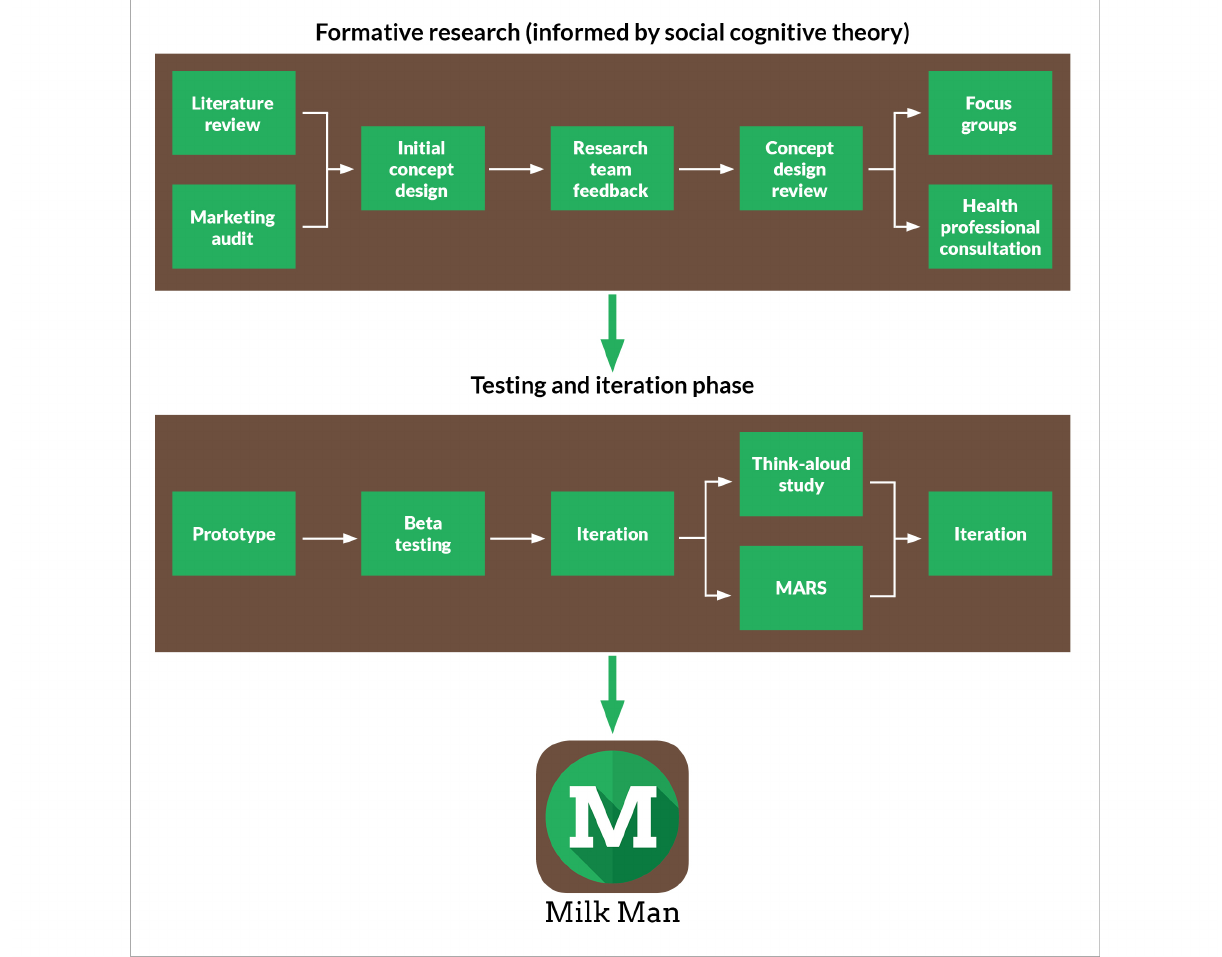
Figure 1. Development process for Milk